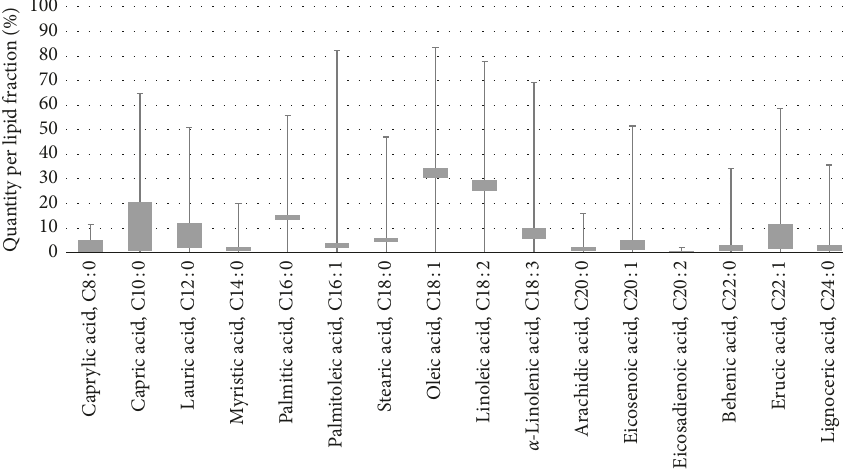
Figure 2: Average minimum and maximum (grey rectangle) and absolute maximum and minimum (interval